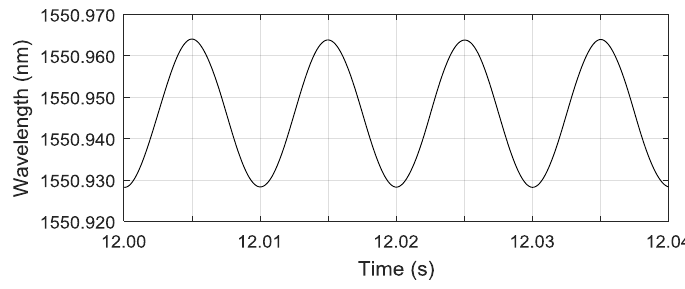
Figure 7. Traditional FBG-based strain measurement system.